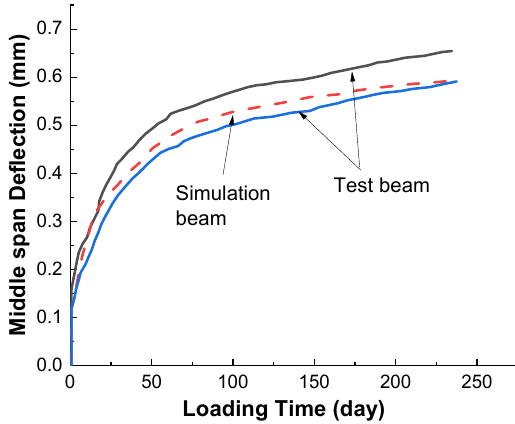
Figure 7. Static load test and simulation results of RC beam.